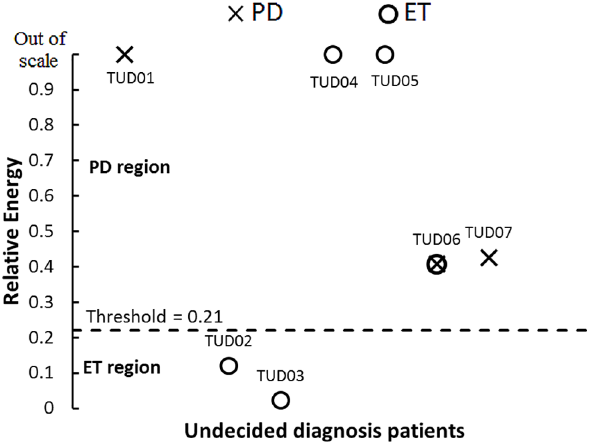
Fig 5. Relative energy threshold was tested with patients with undecided diagnosis at the moment of the recording. 2 out of 2 Parkinson’s diseaseand 2 out of 4 essentialtremor patients were correctly classified.One subject that presentedParkinson’s and essentialtremor concomitance was classifiedas Parkinson’s diseaseby the test. PD, Parkinson’s diseaseET, essentialtremor. AP, atypical